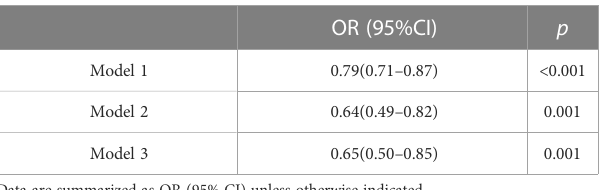
TABLE 4 Association between the SMI and osteoporosis in prediabetes